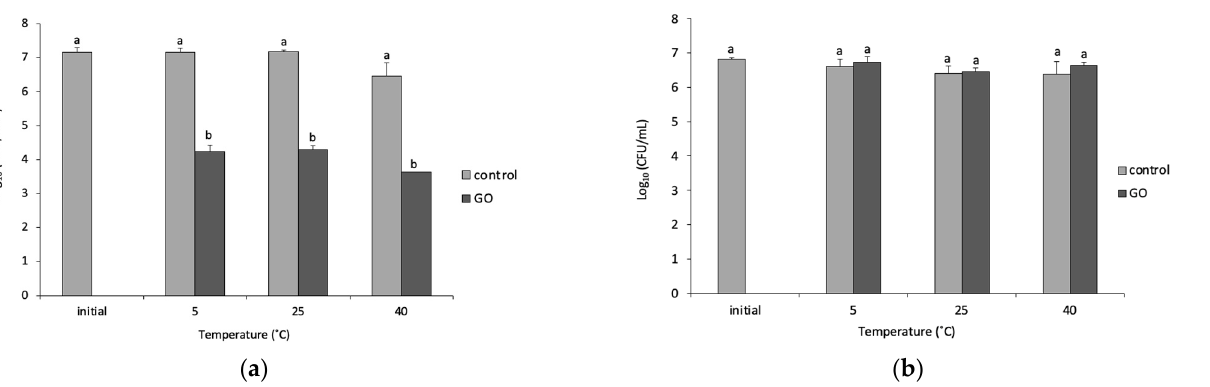
Figure 1. The viability of 48 h P. putida with and without GO incubated at 5, 25 and 40 °C for 24 h ( a ) biofilm and ( b ) planktonic cells. Initial indicates the viability of P. putida after sampling from CDC bioreactor. Mean values with different letters are significantly different ( p < 0.05). Similar letters are non ‐ significantly different, while different letters are significantly different. The data were analyzed with one ‐ way ANOVA.